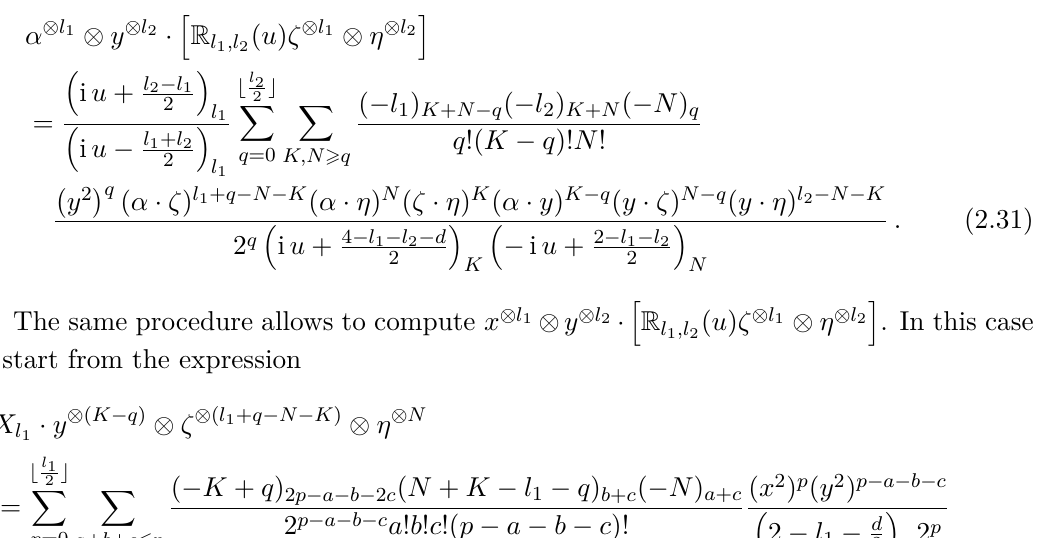
Figure 2 . Graphical representation of a matrix element of the O ( d ) -invariant R -matrix R l and eventually